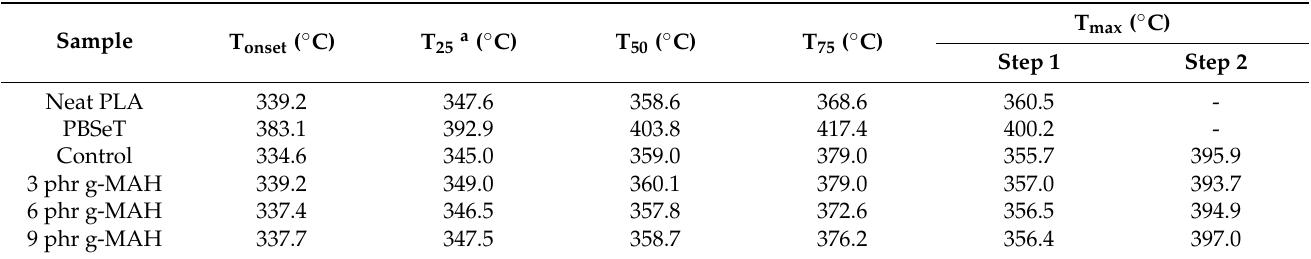
Table 3. TGA data of PLA/PBSeT blends without PLA-g-MAH (control) and various PLA-g- MAH contents.